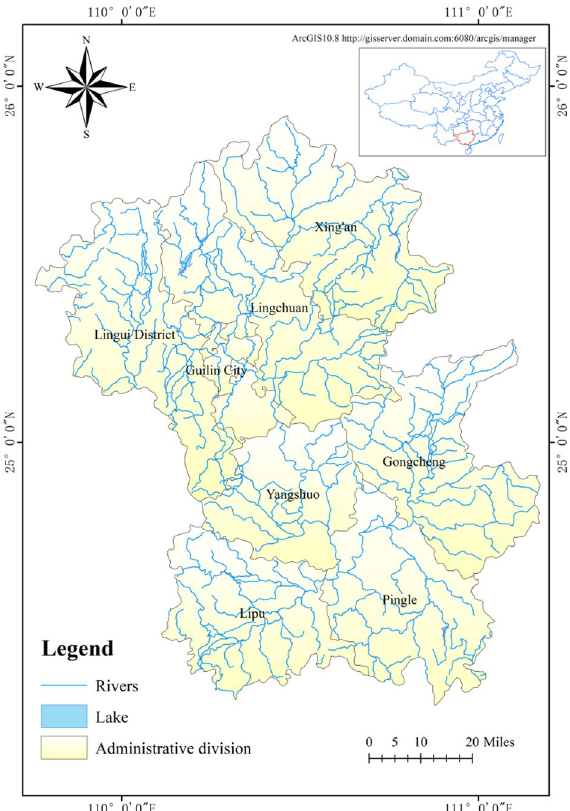
Figure 1. Water system of Lijiang River